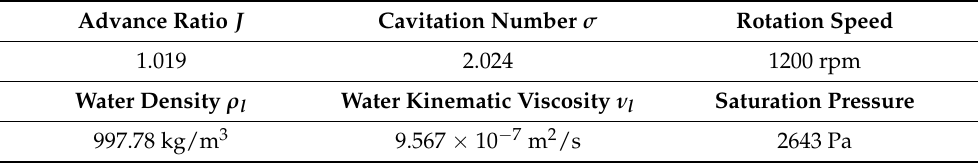
Table 5. Studied operating condition of VP1304.